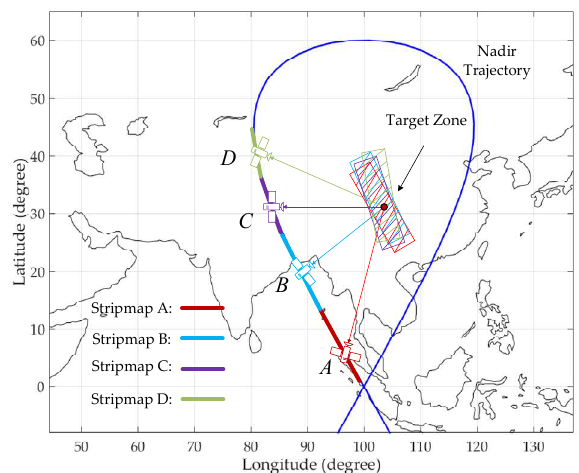
Figure 1. Illustration of a geosynchronous synthetic aperture radar (GEO SAR) observation mode. The red point is the center of the target zone. The blue line on the map represents the nadir trajectory of the GEO SAR platform. The trajectory includes four segments A, B, C, and D denoted by different colors that correspond to separate strip-map observations. A constant squint angle is adopted in each segment, which varies from segment to segment to ensure that the beam center coincides exactly with the red point when the platform resides at the center of each segment. Because the orbit of the GEO SAR platform is extremely high, the overlapping area of the four strip-map observations is sufficiently large to fully image the target zone.